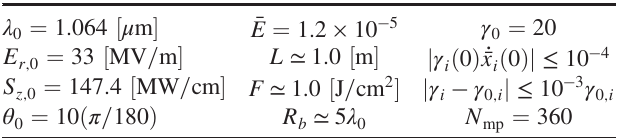
TABLE I. The default values of the parameters used in the various simulations.